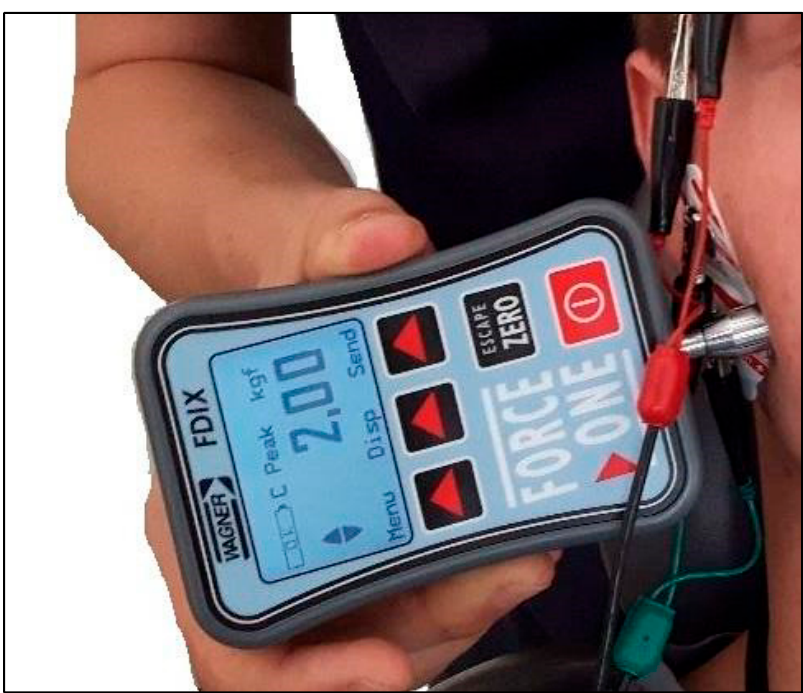
Figure 1. Image of a compression technique over the myofascial trigger point in the masseter muscle performed by pressing with a digital algometer (FDIX, Wagner Instruments, Greenwich, CT, USA).